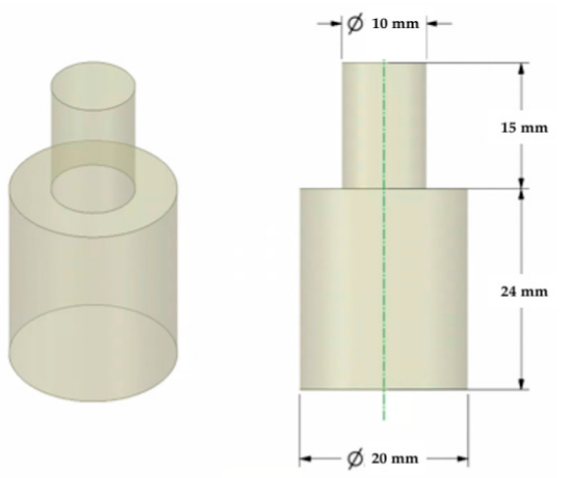
Figure 1. The 3D model of the sample used for the shear test.